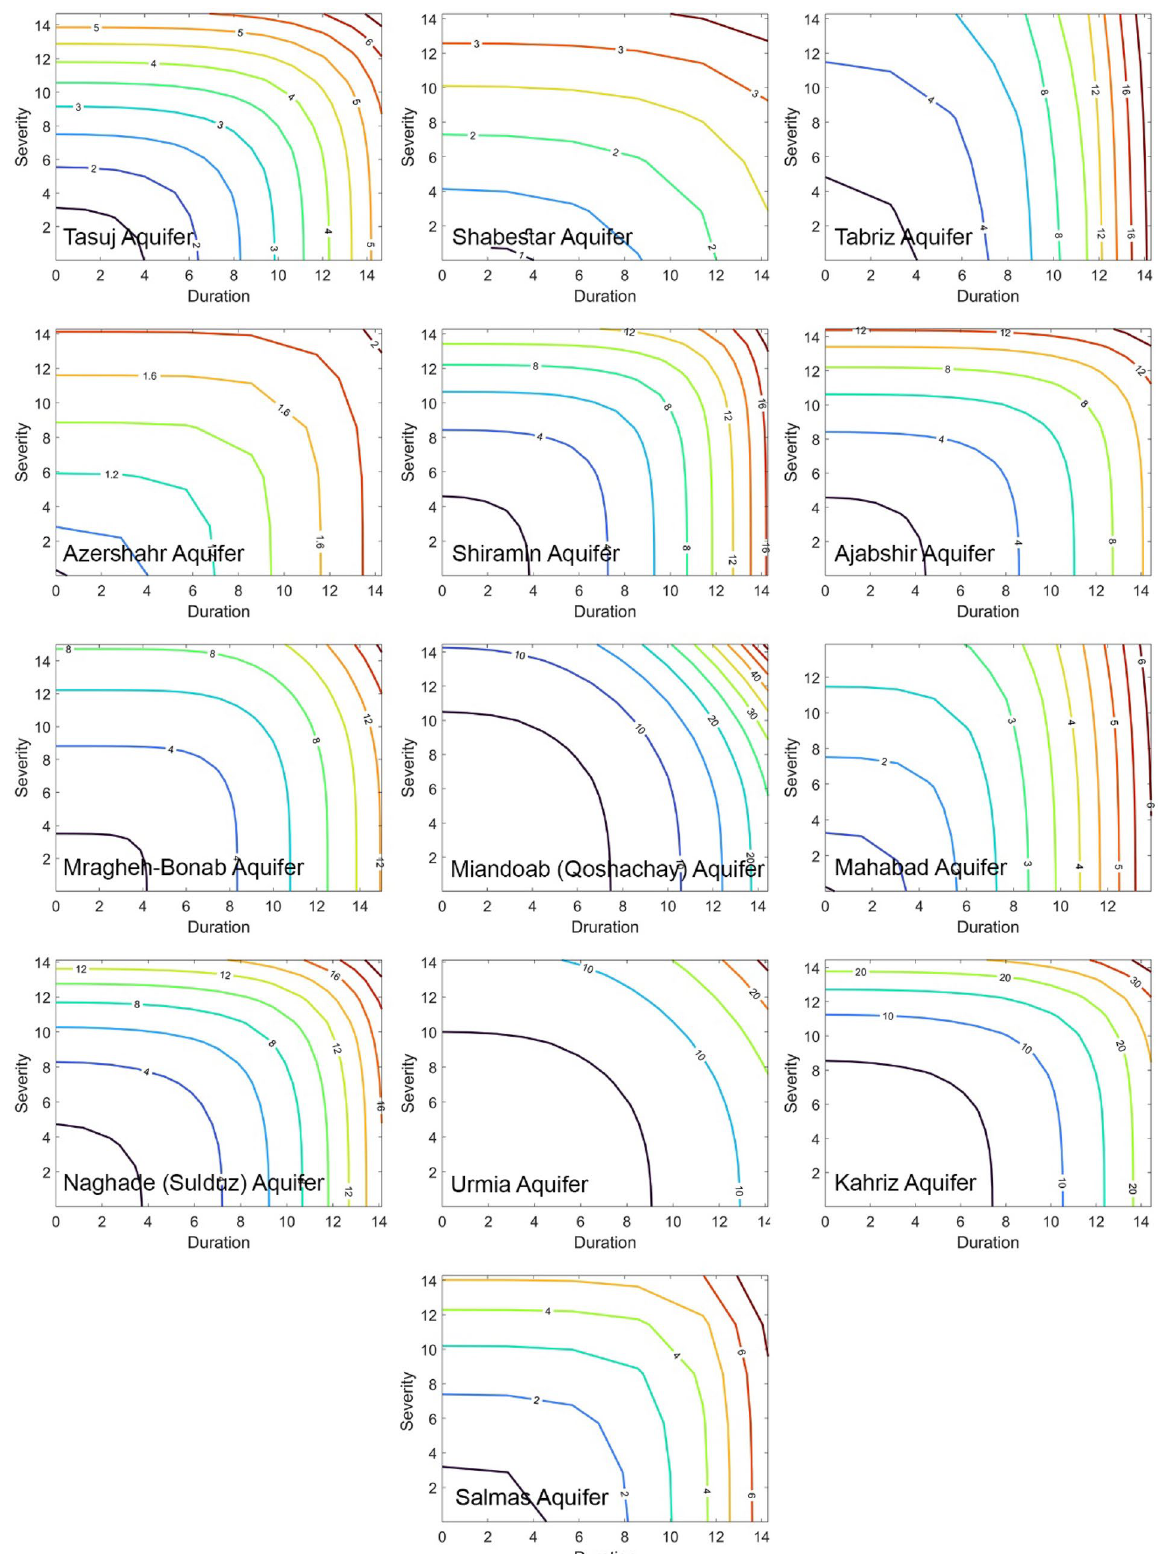
Figure 3. Bivariate return period for GW drought for a sample of observation wells based on fitted